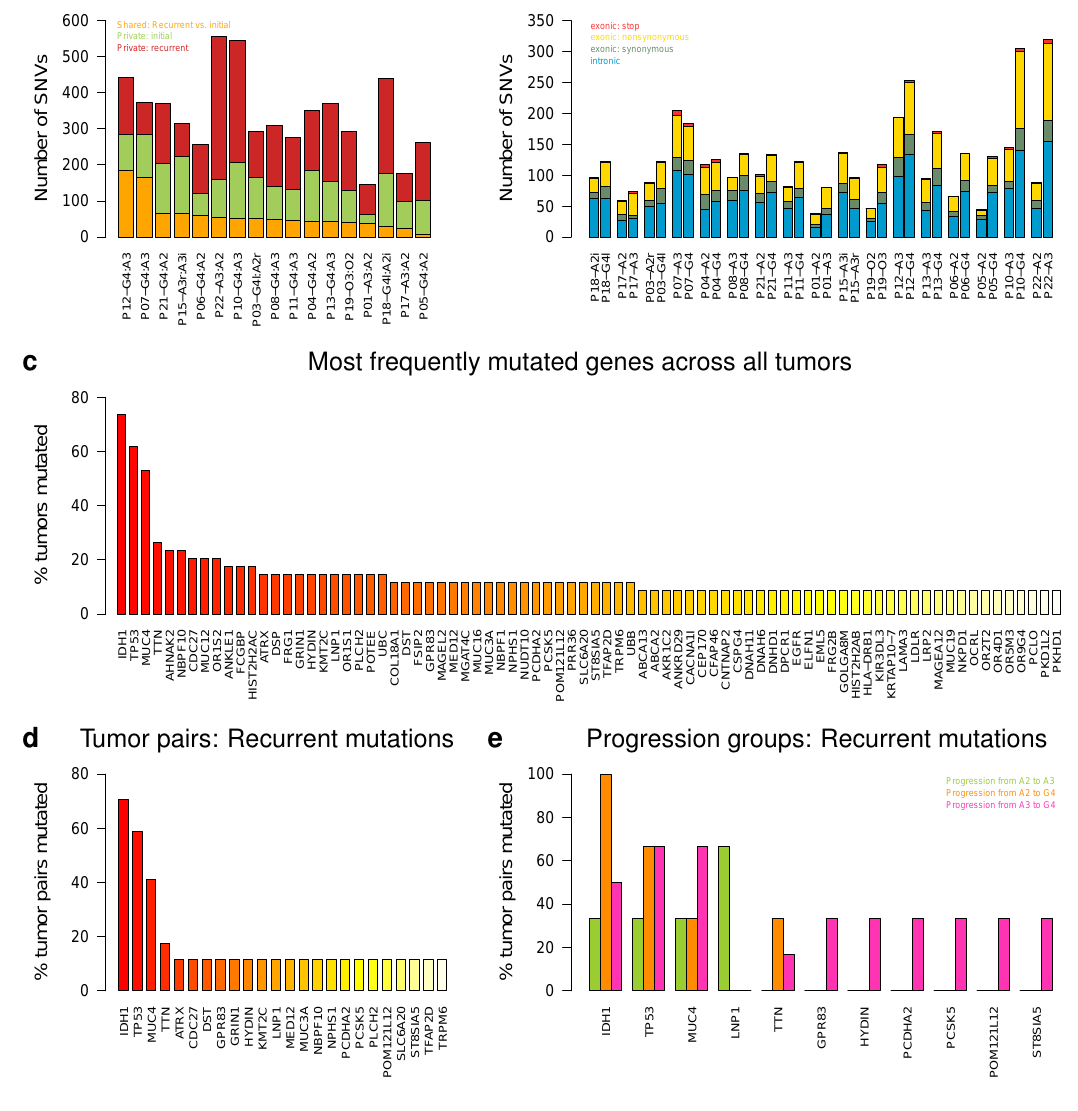
Figure 7. Overview of predicted somatic single nucleotide variations and frequently mutated genes. Somatic SNVs were determined for each patient-matched tumor-normal pair by exome sequencing. Somatic SNVs were further analyzed for individual astrocytomas, patient-matched astrocytoma pairs, and astrocytoma progression groups. ( a ) numbers of somatic SNVs shared between the initial and